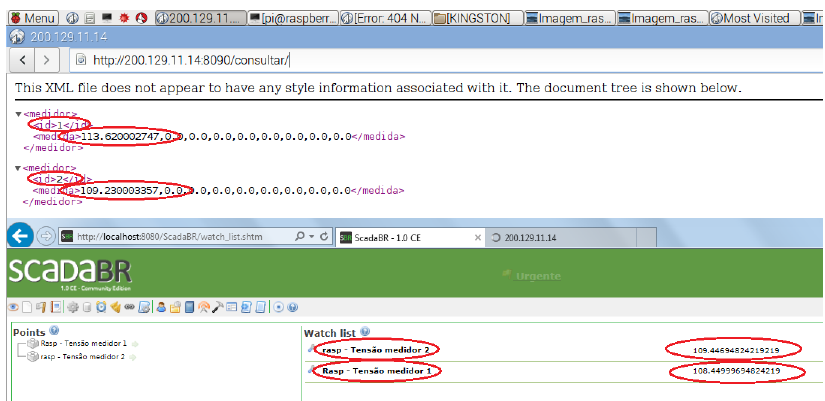
Figure 13. Screenshot of the responses captured by the Scadabr software and the local application with another sensor node inserted.